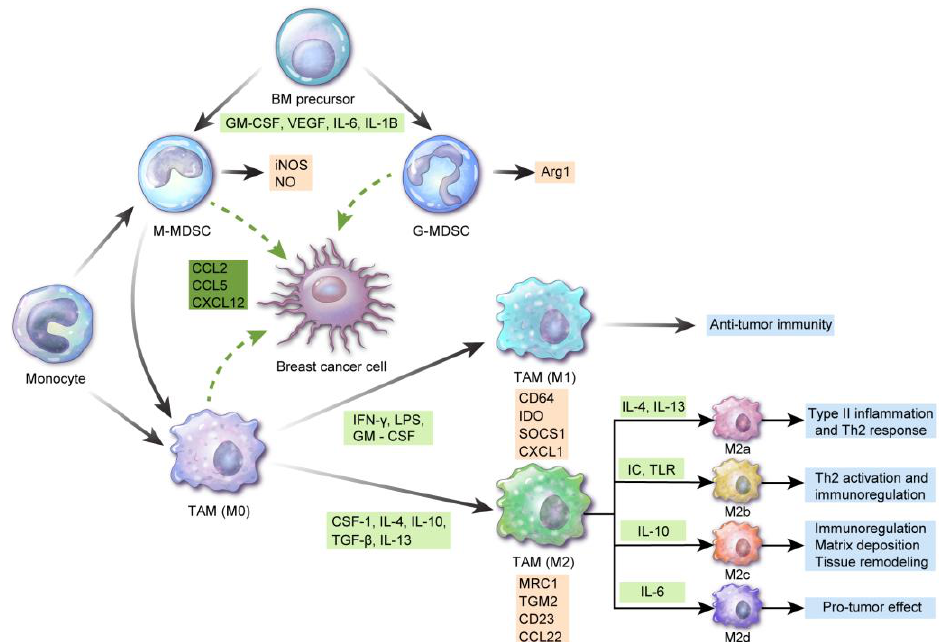
Figure 1. Di ff erentiation and characteristics of tumor-associated myeloid cells: interferon (IFN)- γ , lipopolysaccharide, and granulocyte-macrophage colony-stimulating factor (GM-CSF) induce M1 tumor-associated macrophage (TAM) polarization from monocytes, which are involved in antitumor immunity. CSF-1, interleukin (IL)-4, IL-10, transforming growth factor (TGF)- β , and IL-13 contribute to M2 TAM polarization. M2 macrophages are further di ff erentiated into M2a by IL-4 and IL-13 and are involved in type II inflammation and the Th2 response. Di ff erentiation of M2 macrophages into M2b leads to Th2 activation and immunoregulation via immune complex and toll-like receptor ligand. M2c and M2d di ff erentiation by IL-10 and IL-6 is involved in immunoregulation, matrix deposition and tissue remodeling, and induction and growth of tumor cell masses, respectively. Surface antigens of M1 macrophages include CD64, indoleamine 2,3-dioxygenase (IDO), suppressor of cytokine signaling 1 (SOCS1), and chemokine (C-X-C motif) ligand 1 (CXCL1). Mannose receptor C-type 1 (MRC1), transglutaminase 2 (TGM2), CD23, and C-C Chemokine Ligand 2 (CCL2) are considered M2 macrophage markers. Myeloid-derived suppressor cells (MDSCs) originate from bone marrow precursor cells in the presence of GM-CSF, vascular endothelial growth factor (VEGF), IL-6, and IL-1B and are divided into CD11b + CD14 + HLA-DR − / low CD15 − monocytic MDSCs and CD11b + CD14 – HLA-DR low / − CD15 + granulocytic MDSCs, the former secreting inducible nitric oxide synthase (iNOS) and NO and the latter releasing reactive oxygen species (ROS) and Arg1. Among these, monocytic MDSCs can di ff erentiate to TAMs. In breast cancer, CCL2, CCL5, and CXCL12 are involved in TAM and / or MDSC recruitment.